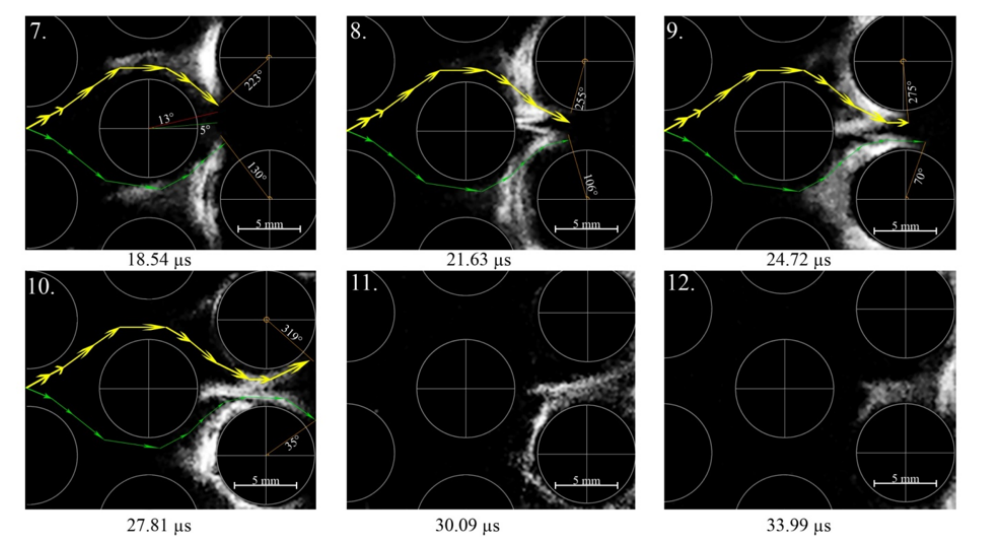
Figure 2. Propagation of the luminosity wave in the pore space. Video frames showing the passage of the reaction wave are shown with corresponding times indicated underneath each frame. The arrows indicate the propagation direction. The angles are used to identify the reaction wave position and subsequent calculation of the local wave velocity. The luminosity is seen to be large behind the reflected wave as it collides with the obstacle (e.g., the middle obstacle in Frame 3) and also in the region behind the obstacle where the two shock waves diffracted around the obstacle collide and give rise to a new shock wave that moves in between the subsequent obstacles (Frames 8 and